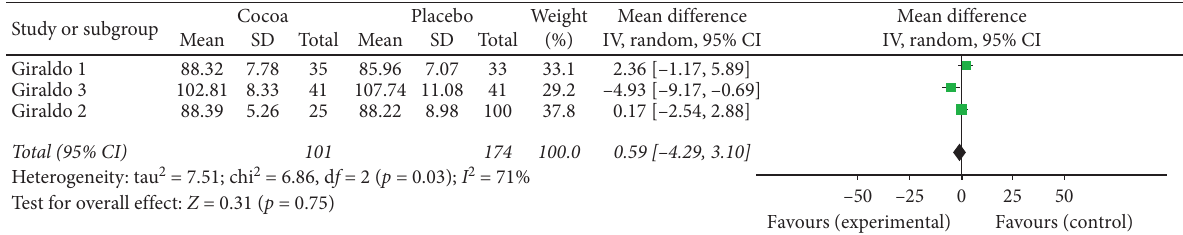
Heterogeneity: tau 2 = 7.51; chi 2 = 6.86, d f = 2 ( p = 0.03); I 2 = 71% Test for overall effect: Z = 0.31 ( p = Figure 7: Meta-analysis of the effect of cocoa consumption on abdominal waist as compared with placebo. The sizes of the data markers indicate the weight of each study in the analysis. IV: inverse variance.